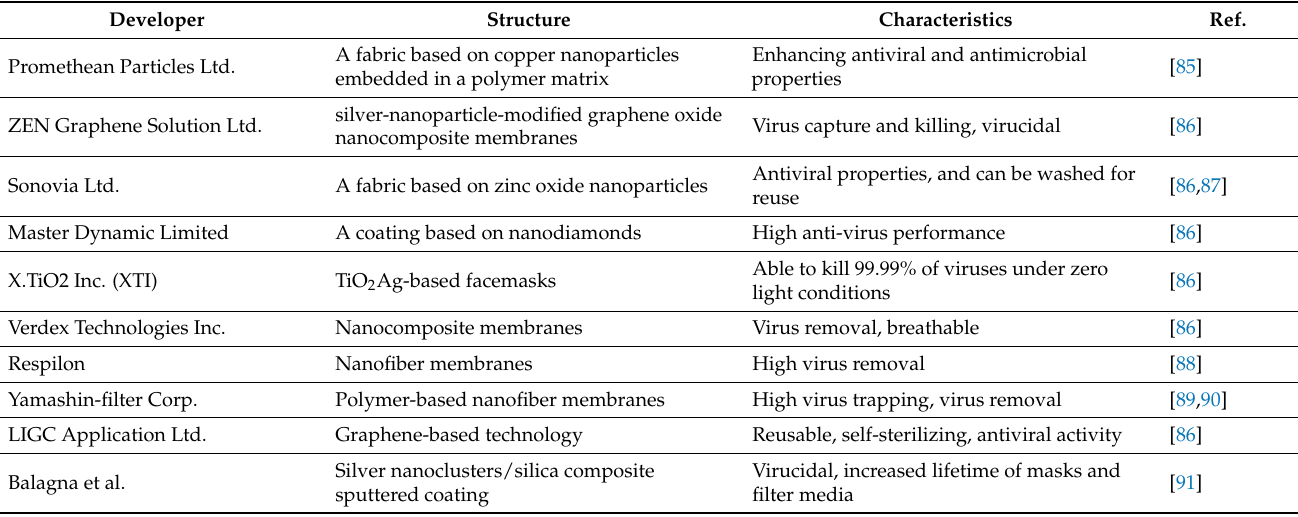
Figure 4. PPE for health care workers; safe PPEs for health care workers include visor respirator, visor, gloves, and gown. FFP2/N95 respirator and surgical mask provide protection against airborne viruses and larger particles, respectively. A disposable medical gown provides protection from blood and liquid. At the same time, the steps of placing and removing PPEs are very important for regulating health care. Reproduced with permission from [84]. Copyright American Chemical Society, 2020. Table 2. Nano-based disinfectant personal protective equipment